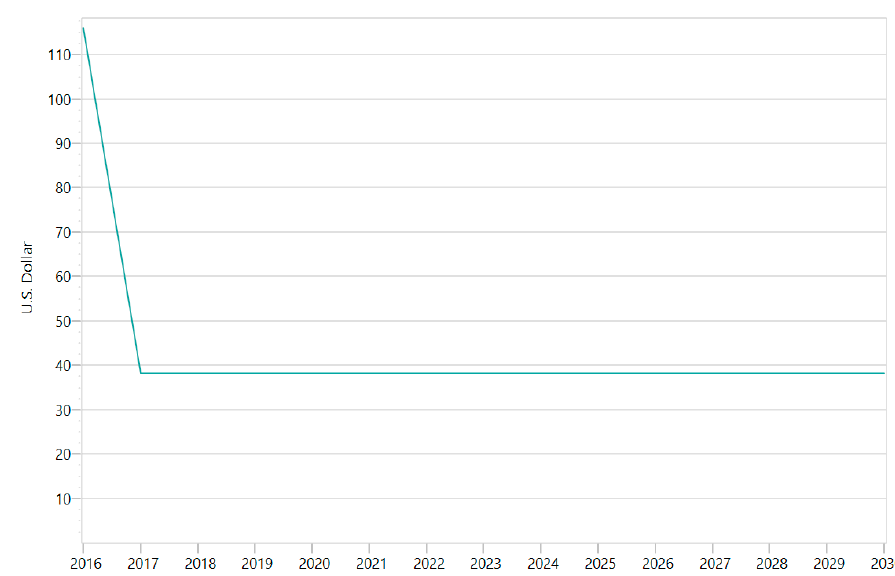
Figure 6. Annualized cost of improved stoves for the commercial sector.